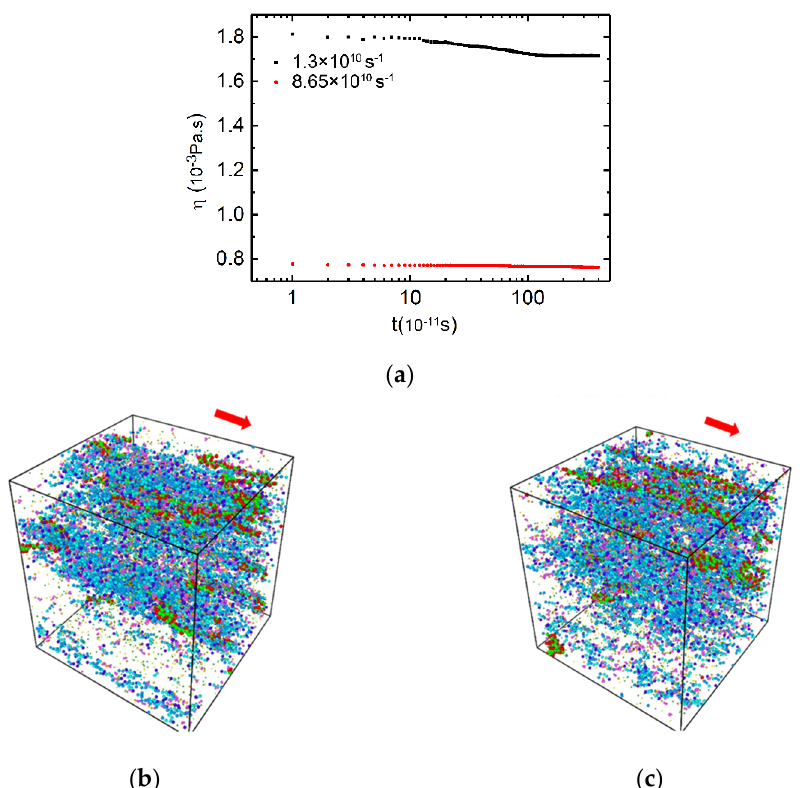
Figure 3. ( a ) Shear viscosity versus time at medium and high shear rates for mixtures shown in logarithmic axis. C CTAC = 0.2 mol · L − 1 , C PAM = 2.96 × 10 − 3 mol · L − 1 , counter ion salt is NaSal, R is 0.8, T = 300 K. Black square: shear rate is 1.3 × 10 10 s − 1 . Red circle: shear rate is 8.65 × 10 10 s − 1 . ( b ) Snapshot of the PAM based solution at 4 ns at a shear rate of 1.3 × 10 10 s − 1 . ( c ) Snapshot of the PAM based solution at 4.4 ns at a shear rate of 8.65 × 10 10 s − 1 . Color scheme: purple, hydrophilic part of CTAC; cyan and blue, hydrophobic tail of CTAC; magenta, aromatic ring of Sal - ; khaki, charge group of Sal − ; yellow, Na + ; dark green, Cl − ; red, the acidammide group of PAM; green, carbon backbone of PAM. Water sites (reddish) and antifreeze water sites (grey) were hidden for clear display. The applied flow direction is indicated by a red arrow in (b) and (c).